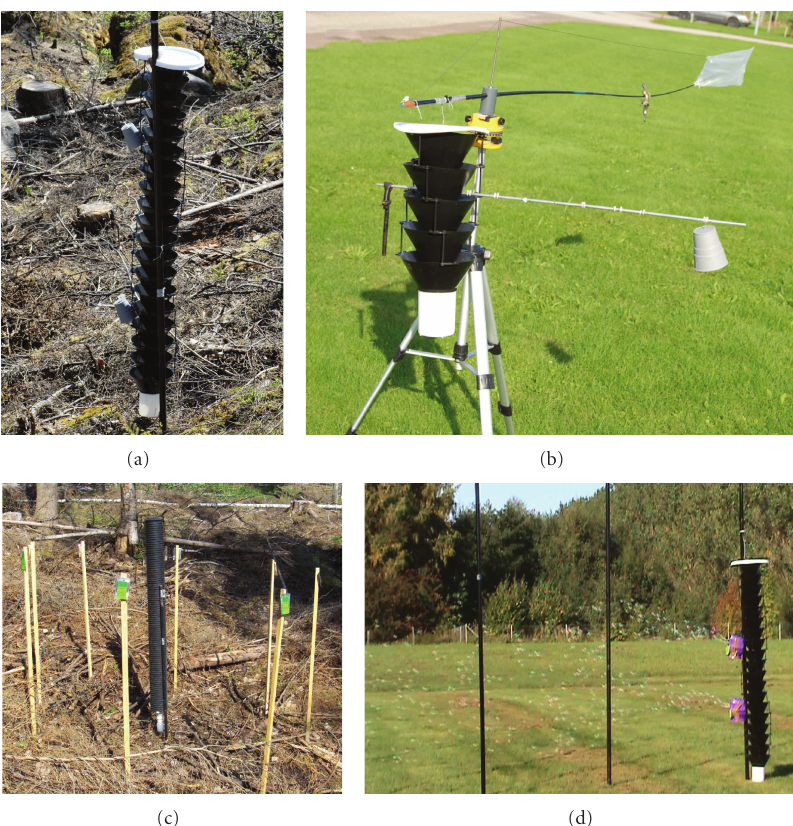
Figure 7: (a) Lindgren funnel traps (19-funnel size) were used in the vertical spacing tests with Ips typographus . Dispensers positioned under grey cups. (b) A Lindgren trap (5-funnel size) was attached to a wind vane in the horizontal spacing tests to ensure constant distance between plumes. (c) Pipe trap surrounded by eight nonhost volatile dispensers in the antiattractant background tests. (d) Soap bubble visualization of vertical plume overlap at a spacing distance of 48 cm. Distance between black poles = 1m (modified from